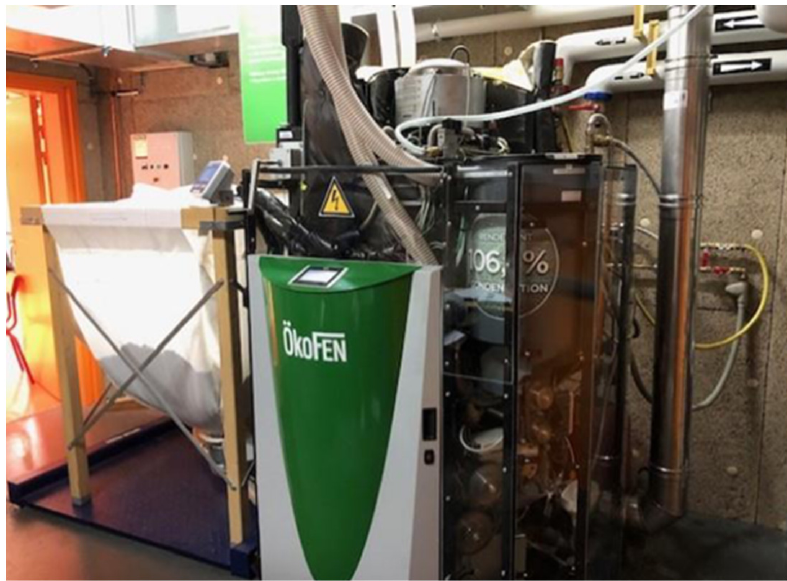
Figure 5. Micro-CHP unit installed in laboratory@ Paris Nanterre University. Table 1. Experimental results of ÖkoFEN micro-CHP units tested in our laboratory (LEME). Micro-CHP Unit FPSE Manufacturer Heat Source